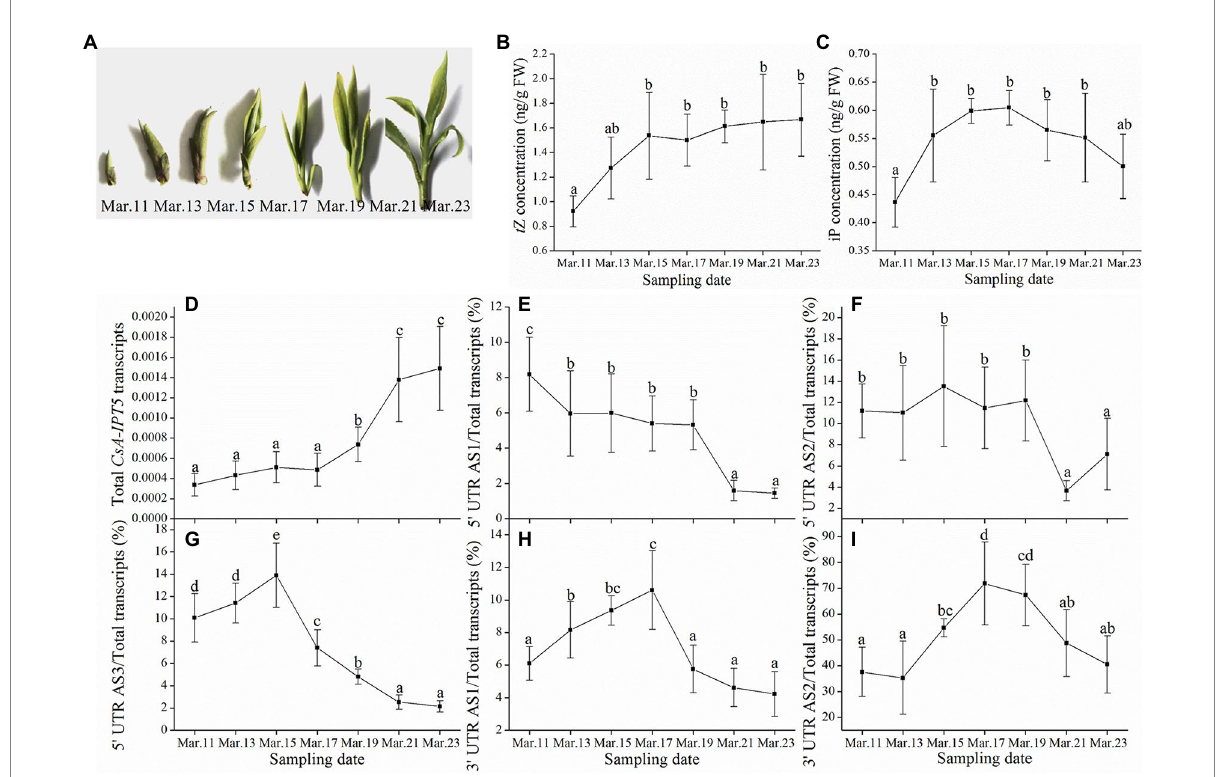
FIGURE 1 The phenotypes of the axillary buds, cytokinin (CK) concentrations, and the transcriptional levels of CsA-IPT5 transcripts during the course of spring tea development. The phenotypes of the axillary buds (A) and CK concentrations in the axillary buds (B–C) during the process of spring tea development. The transcription levels of total CsA-IPT5 transcripts (D) and the expression ratio of each CsA-IPT5 splice variation (E–I) during the process of spring tea development. Data are means ± SD ( n = 6). For each figure, letters represent marked differences in the index among different time points ( p < 0.05, Duncan’s multiple range